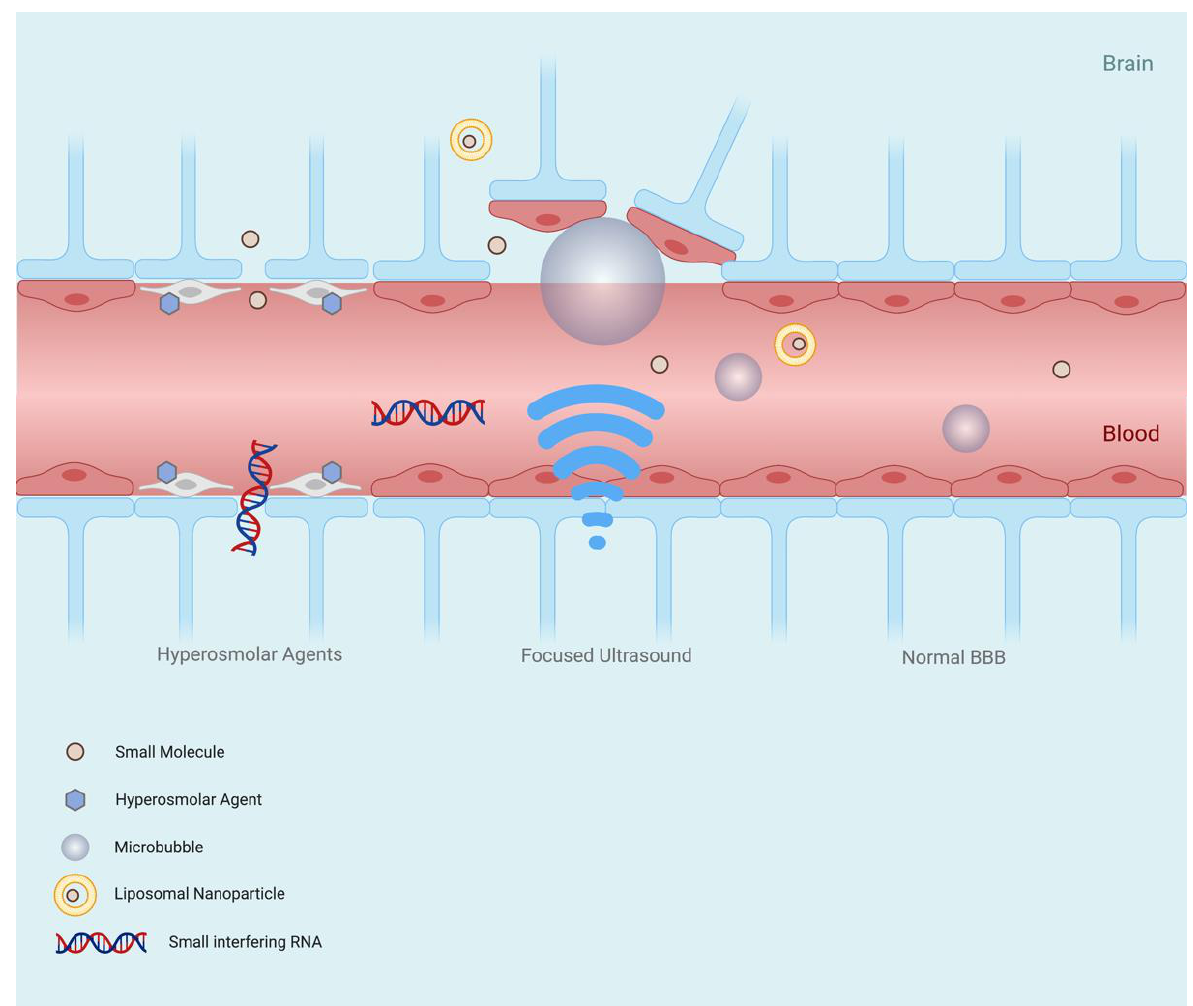
Figure 3. Blood–brain barrier modulation mechanism of focused ultrasound and hyperosmolar agents. Hyperosmolar agents disrupt the blood–brain barrier by dehydrating endothelial cells in the vascular lumen, causing them to contract. The shrinking of the cells leads to the opening of TJ gaps, enabling enhanced and indiscriminate paracellular flow of solutes. Exposure of microbubbles within brain capillaries to ultrasound waves induces rapid expansion and contraction, disrupting the microvascular endothelial cells of the blood–brain barrier and creating cavitation sites at a sensitivity greater than direct FUS. Additionally, the power required to induce blood–brain barrier disruption is lowered by 100-fold, falling below the levels required to damage tissue.